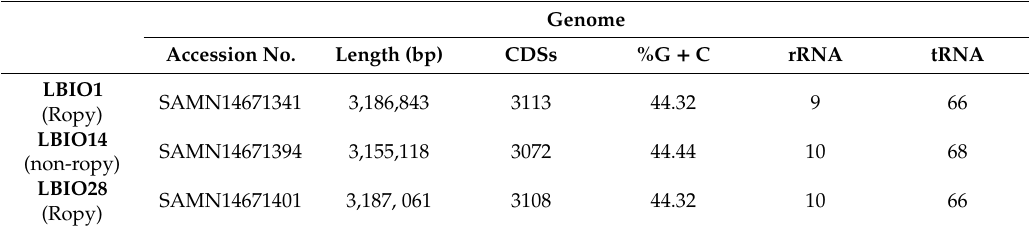
Table 1. Some features of the genomes from the L. plantarum strains used in this study. The LBIO1, LBIO14 and LBIO28 genome sequences are available in the GenBank database (http: // www.ncbi.nih. gov /